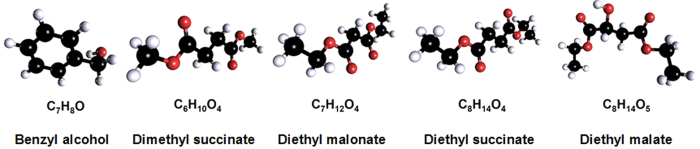
Molecular structure of selected odorants.